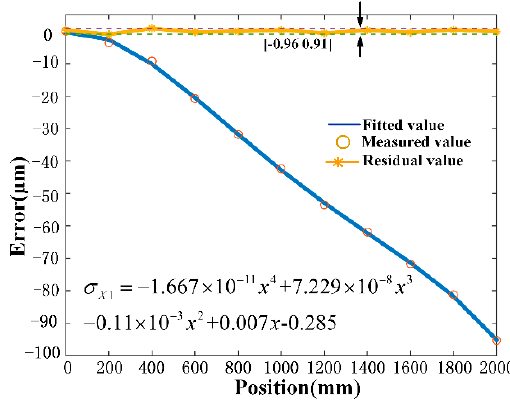
Figure 12. The fitting curve of x 1 -axis positioning errors.